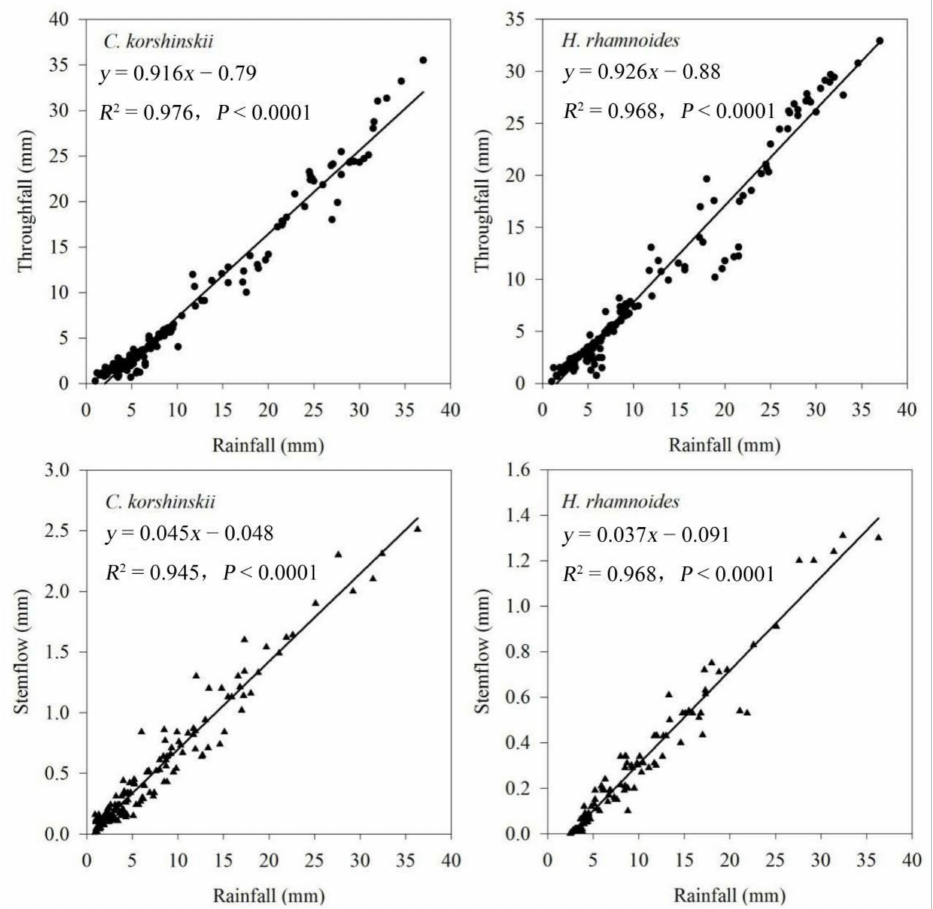
Figure 3. Linear regression relationship between rainfall and throughfall or stemflow from 2014 to 2018 for C. korshinskii and H. rhamnoides